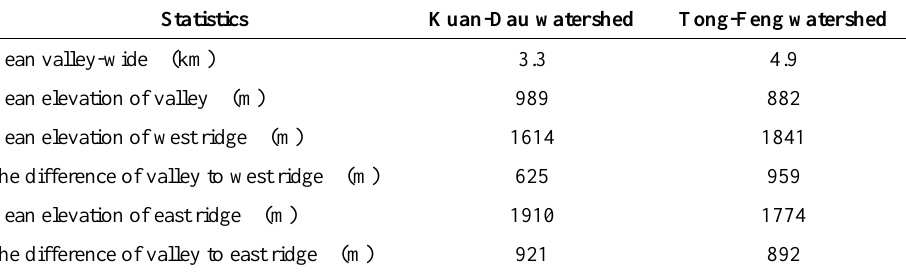
Table 1. Microterrains of the two watersheds